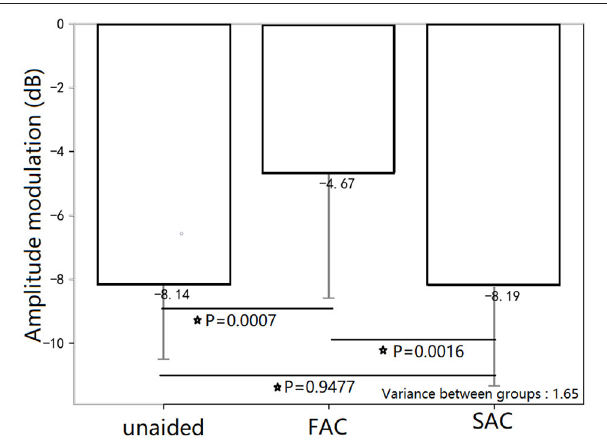
FIGURE 3 | Mean temporal modulation discrimination thresholds for the three HA conditions. The unaided temporal modulation thresholds and the aided temporal modulation thresholds in the SAC condition were better than that in the aided FAC condition. There was no significant difference in temporal modulation thresholds between unaided and aided SAC conditions. The * symbol means statistically significant.